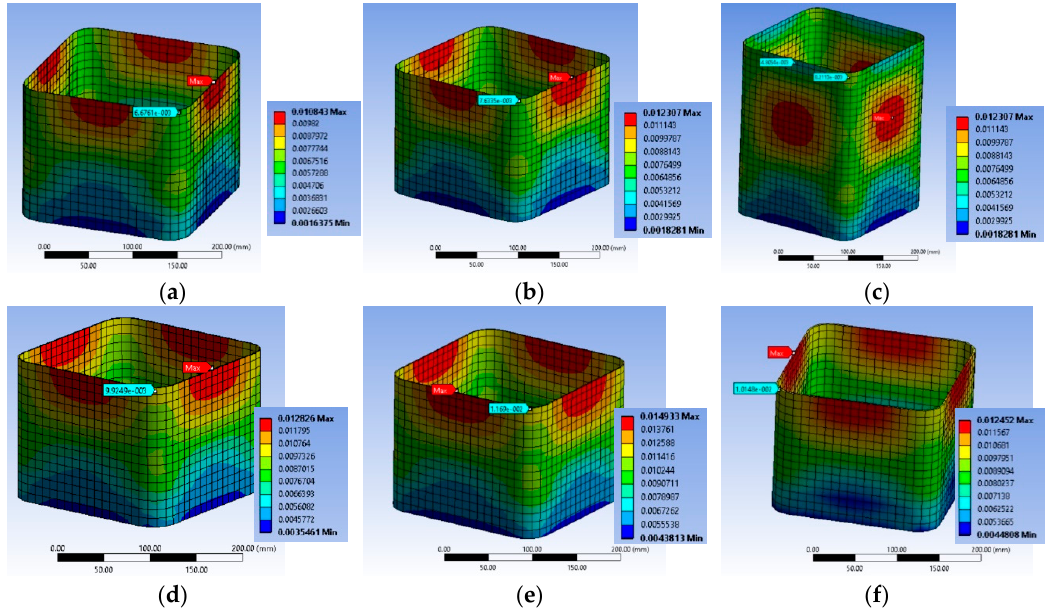
Figure 6. Variation of the Carbon Fiber Reinforced Polymers (CFRP) strain and characteristic values of specimen BS1C1C ( a ) one step after the first concrete damage at the mid-height of the column; ( b ) at the ultimate condition at the mid-height of the column and ( c ) at the ultimate condition at the level of the stirrup; BS1C3C ( d ) one step after the first concrete damage at the mid-height of the column and ( e ) at the ultimate condition at the mid-height of the column and ( f ) BS1C5C at the ultimate condition at the mid-height of the column.